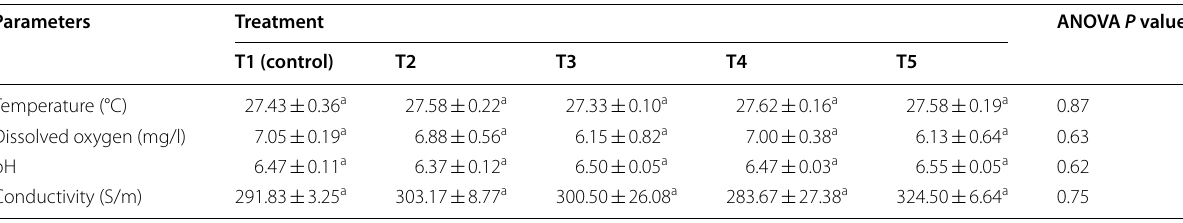
Figures in each row having the same superscripts are not significantly different ( P > 0.05) Mean in a given row with the same letter a, b, c, d or e were not significantly different at ( P > 0.05)